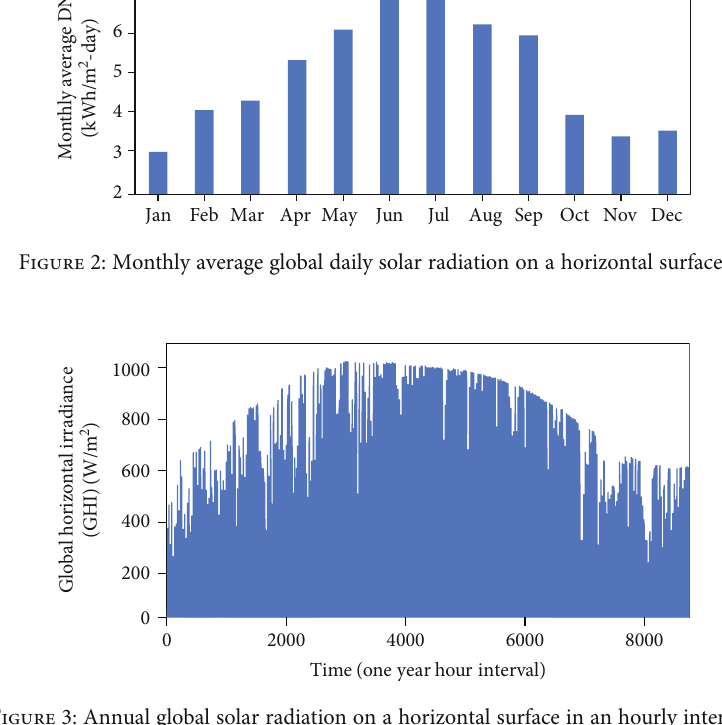
Figure 3: Annual global solar radiation on a horizontal surface in an hourly